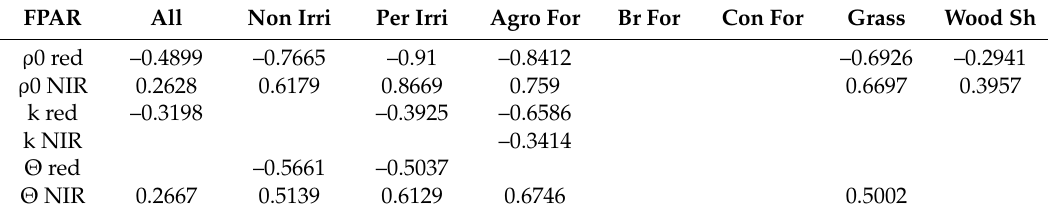
Table 4. Spearman correlation coefficient from the FPAR and each of the MRPV parameters. In the second column, the Rho’s from all seven MISR orbit pixels is shown. Missing cells